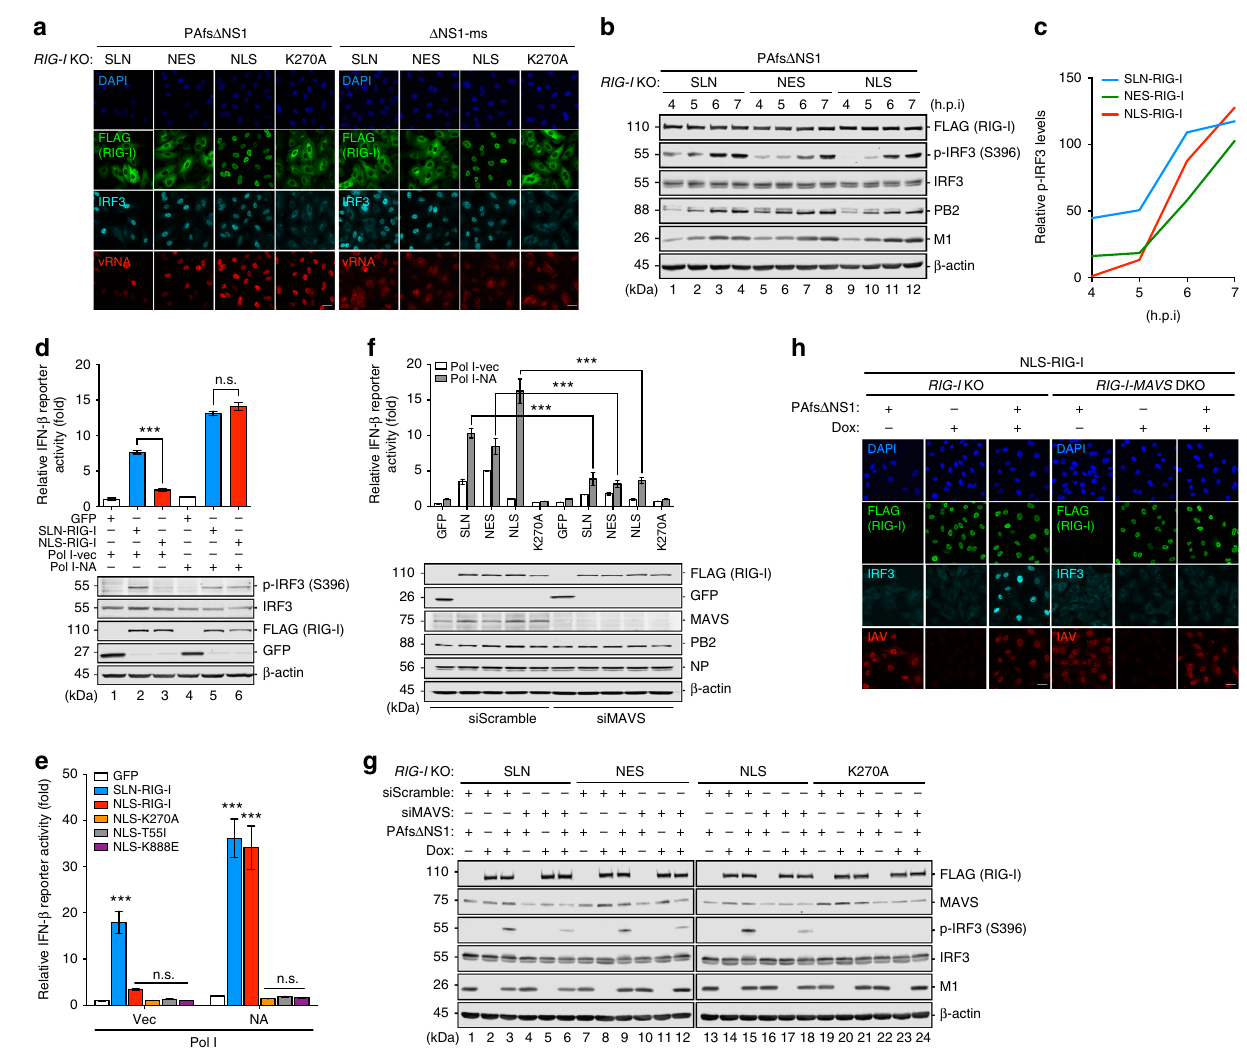
Fig. 4 Nuclear RIG-I senses IAV via the canonical signaling axis. a A549 RIG-I KO cell lines inducibly expressing SLN-RIG-I, NES-RIG-I, NLS-RIG-I, or K270A-RIG-I were induced with 1 μ g/mL Dox for 4 h followed by infection with PAfs Δ NS1 or Δ NS1-ms (MOI = 10) for 7 h. The cells were subjected to immuno fl uorescence for FLAG-RIG-I (green) and IRF3 (cyan), and FISH for M vRNA (red). b Dox-induced A549 cell lines were infected with PAfs Δ NS1 virus (MOI = 10). At indicated h.p.i, the protein expression was determined by immunoblotting. c Kinetics of IRF3 phosphorylation ( b ) normalized to total IRF3 and β -actin levels were determined by densitometric analysis (ImageJ). d , e 293T cells were RNP reconstituted with Pol I vector or PR8 NA segment in the presence of GFP, SLN-RIG-I, or NLS-RIG-I ( d ), or in the presence of NLS-RIG-I harboring K270A, T55I, and K888E mutations ( e ) for 24 h. The protein expression was determined by immunoblotting ( d ). RLUs are expressed as fold change relative to the Pol I vector reconstitution in the presence of GFP ( d , e ). f 293T cells were transfected with 10 nM scramble siRNA (siScramble) or MAVS siRNA (siMAVS) for 24 h followed by RNP reconstitution in the presence of GFP or various RIG-I constructs for another 24 h. RLUs are expressed as that in d and e . Data are shown as mean ± SD of three experiments. Signi fi cant differences were determined by an unpaired Student ’ s t- test ( d ) or one-way ANOVA followed by Tukey post-test ( e , f ). *** p < 0.001; n.s. not signi fi cant. g Inducible A549 cell lines were transfected with 10 nM indicated siRNA for 40 h, followed by Dox induction (4 h) and PAfs Δ NS1 infection (MOI = 10, 6 h). The protein expression was determined by immunoblotting. h A549 RIG-I KO and RIG-I-MAVS DKO cell lines complemented with NLS- RIG-I were left non-induced, or Dox-induced followed by mock or PAfs Δ NS1 infection (MOI = 10, 8 h). Immuno fl uorescence was performed to detect FLAG-RIG-I (green), IRF3 (cyan), and IAV (red). Nuclei were stained with DAPI (blue). Scale bar = 25 μ m ( a , h and NES-RIG-I at 24 h.p.i (Fig. 5c, lane 10 vs. lanes 2 and 6, compared to non-Dox induced lanes). NLS-RIG-I expression also led to reduced virus titer, albeit to a lesser extent compared to SLN-RIG-I and NES-RIG-I (Fig. 5d). No inhibitory effect on viral protein accumulation and titer was observed in RIG-I-MAVS DKO cells expressing either RIG-I (Fig. 5c, d). In line with pre- vious studies 26,45 , the signaling-inactive K270A mutant of RIG-I, albeit de fi cient in IFN-inducing capacity (Fig. 5a, b), consistently exhibited an antiviral effect to some extent. Such signaling- independent activity also required MAVS (Fig. 5c, d).